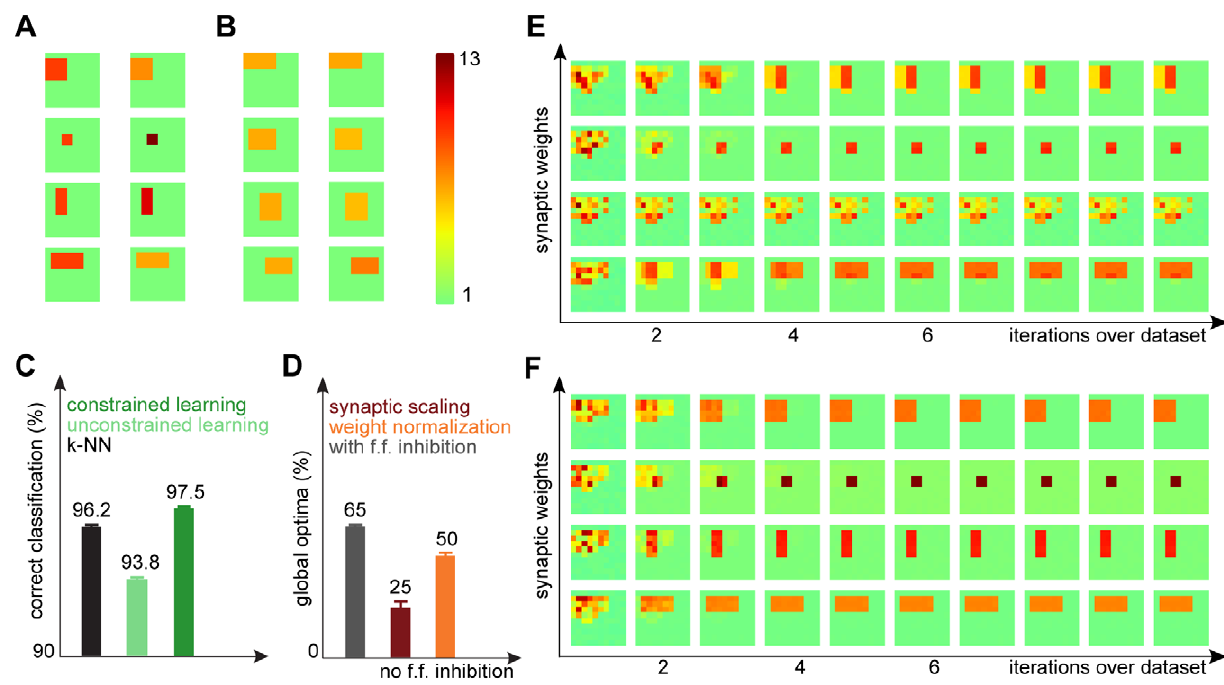
Figure 5. The contribution of feedforward inhibition and synaptic scaling to learning. (A) An example set of generative fields for unconstrained (left column) and normalized (right column) data. The overall average intensity across all fields is constrained to facilitate the comparison of learning with different models. (B) Same as before, but with rectangles of similar sizes. (C) Rate of correct classification for optimal learning with constrained vs. unconstrained data. (D) Rate of convergence to global optima when learning from (un)constrained data with the linear network model, when weights are constrained either by local synaptic scaling, or through explicit normalization. All estimates are computed out of 100 trials. (E) Evolution of the synaptic weights when synaptic scaling is implemented either by synaptic scaling or (F) as instantaneous weights normalization, for an example run.